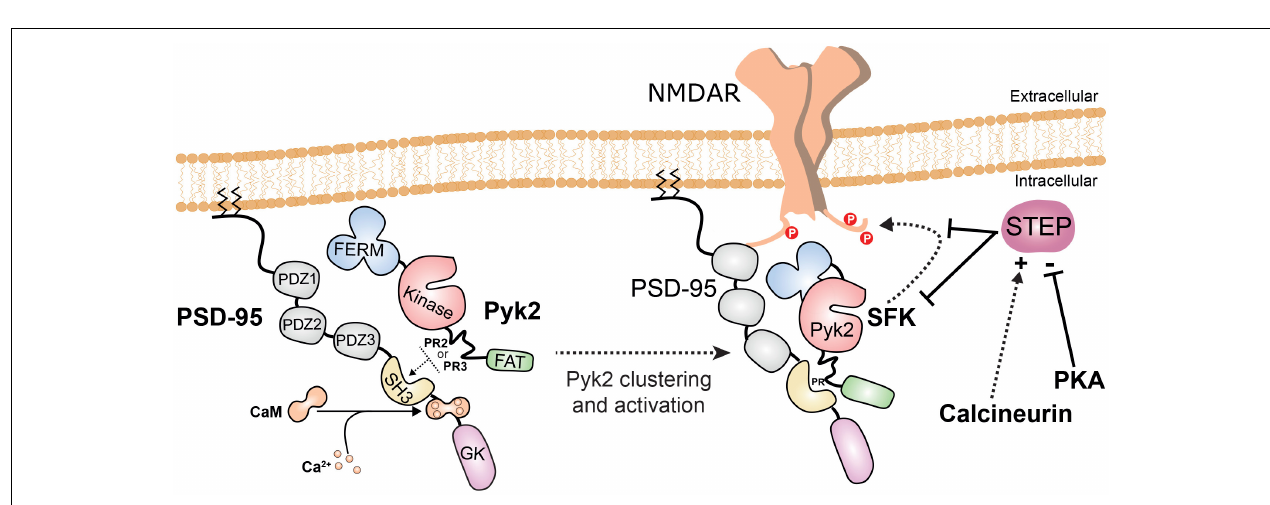
FIGURE 4 | Pyk2 recruitment and activation in post-synaptic densities. When intracellular Ca 2 + increases, Ca 2 + /calmodulin (CaM) interacts with the PSD-95 region between its SH3 and guanylate kinase-like (GK) domains (Seabold et al., 2003; Bartos et al., 2010). This makes the SH3 domain available for interaction with PR2 or PR3 motifs in Pyk2 and facilitates its enrichment in PSDs. Pyk2 can also interact with other PSD proteins (SAP102, SAPAP3) but the regulation and dynamics of these interactions have not been investigated. The binding of Ca 2 + /calmodulin to PSD-95 favors dimerization of PSD-95 and clustering and activation of Pyk2, which is in the vicinity of NMDAR. Ca 2 + /calmodulin can also bind directly to and activate Pyk2 (not shown, see Figure 2 ). Pyk2 and the associated SFKs, presumably mostly Fyn and Src, phosphorylate NMDAR on tyrosine. One consequence of tyrosine phosphorylation of NMDAR is to increase its surface expression. The main phosphatase which opposes these effects by dephosphorylating tyrosine residues on Pyk2, SFKs, and NMDAR is STEP. STEP is inhibited by phosphorylation by cAMP-dependent protein kinase (PKA) and indirectly activated by the Ca 2 + -activated phosphatase